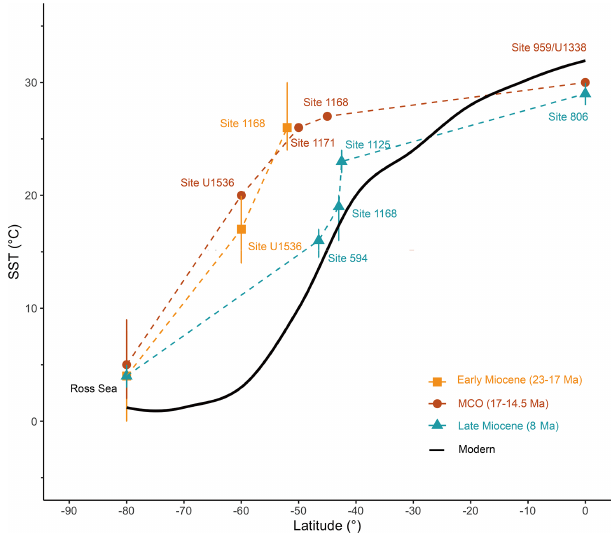
Figure 7. Sea surface latitudinal temperature gradient in the South- ern Hemisphere for the early Miocene (orange; 23–17Ma), MCO (red; 17–14.5Ma), late Miocene (blue; 8Ma) and modern at 160 ◦ E (black; based on Fig. 1d), respectively. Error bars indicate the vari- ability of the time range. Paleo data are from the sources in Fig. 6, except for the MCO SSTs at the Equator, which are from Rousselle et al. (2013) and Van der Weijst et al.